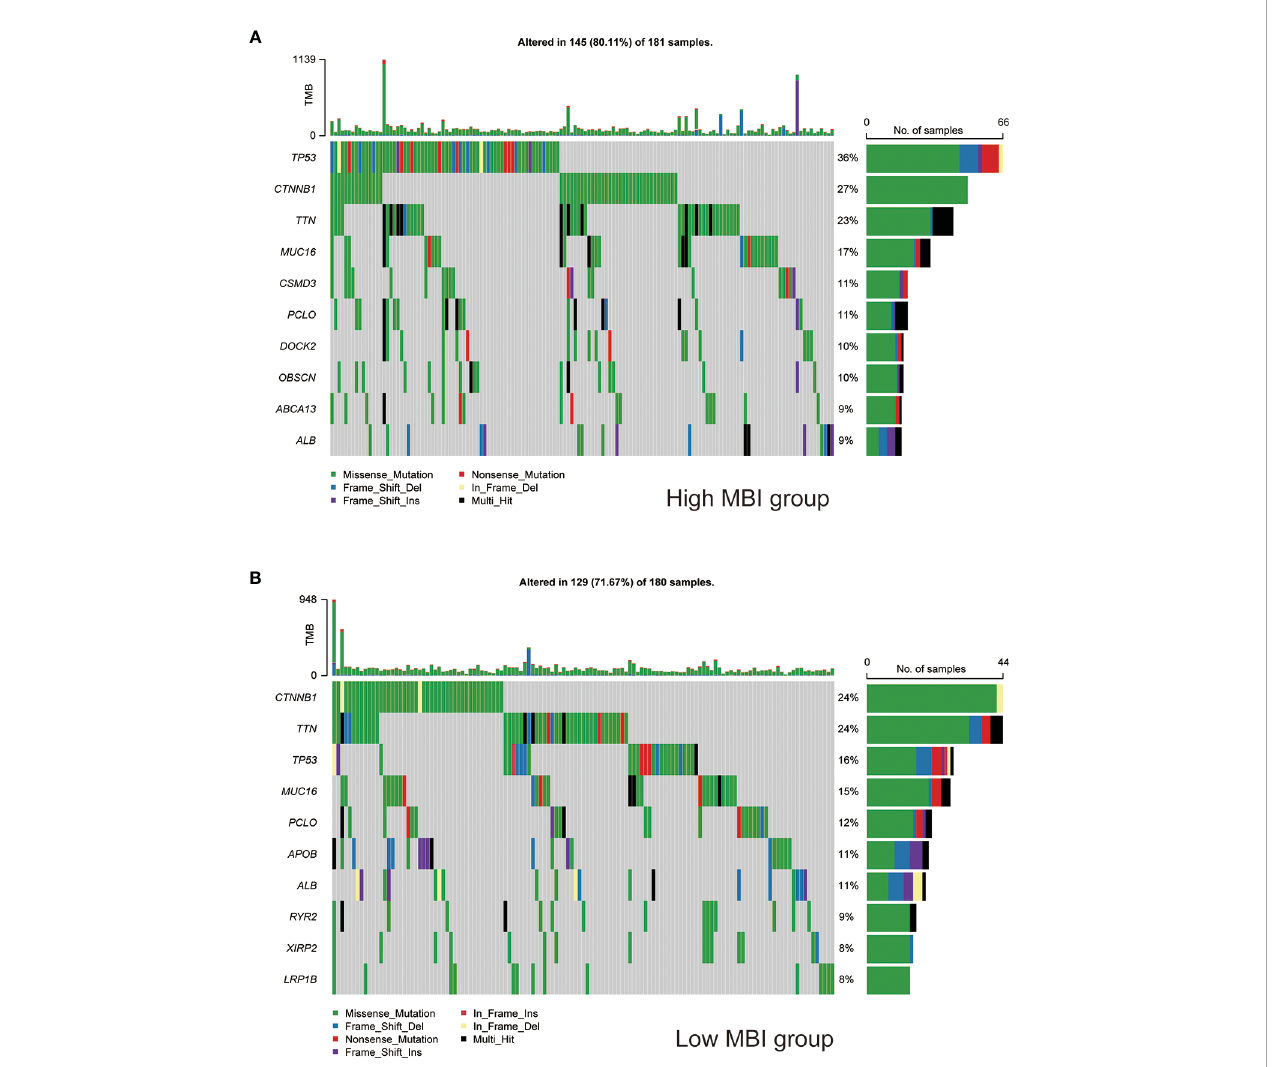
FIGURE 6 Mutation landscape of different MBI groups. (A) Mutation types, mutated genes and mutation frequencies in patients in the high MBI group. (B) Mutation types, mutated genes and mutation frequencies in patients in the low MBI